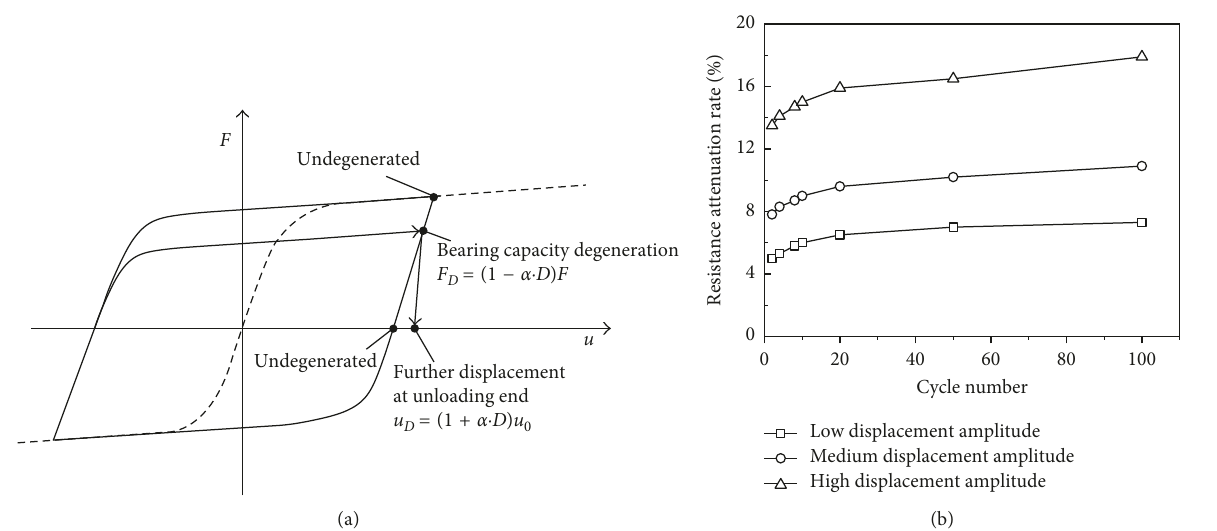
Figure 6: Ballast resistance performance subjected to durable dynamic reciprocated changes: (a) bearing capacity degeneration of granular ballast beds and (b) attenuation rate of ballast ultimate